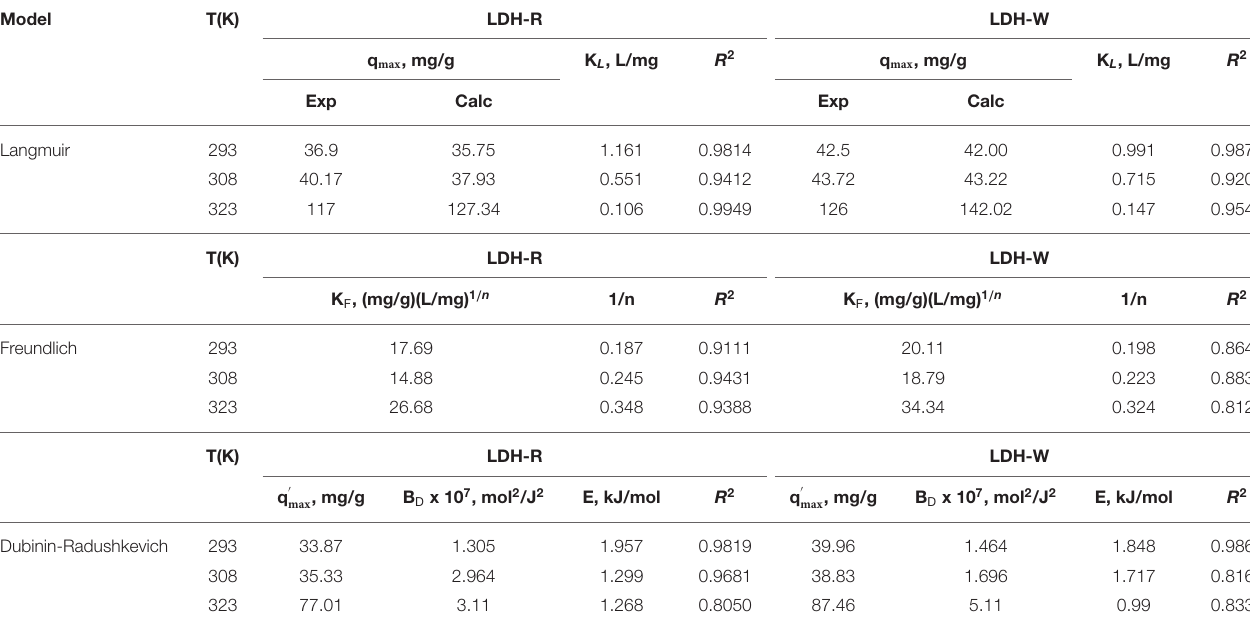
TABLE 2 | Equilibrium parameters for Orange II adsorption onto LDH-R and LDH-W.